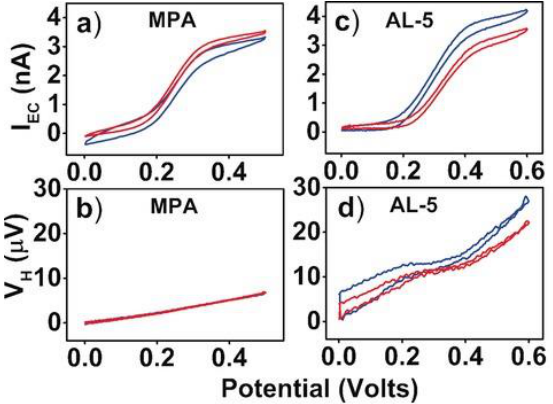
Figure 7. The enantio-selectivity data for devices coated with achiral molecules (a,b) and with chiral AL-5 (c,d) with chiral R-and S-ferrocene derivatives (blue and red curves, respectively) (Reproduced with permission from [28], WILEY-VCH, 2017).